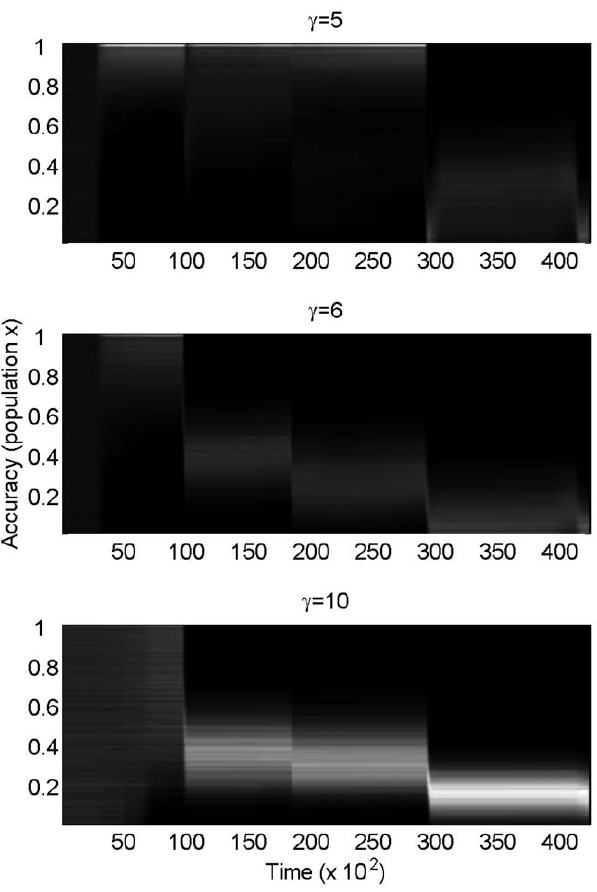
Figure 4. Agent discrimination ability using the Vostok ice core data. From top to bottom: c ~ 5, c ~ 6, c ~ 10 . Notice how discriminatory ability rises during periods of slow change, but falls each time there is a rapid